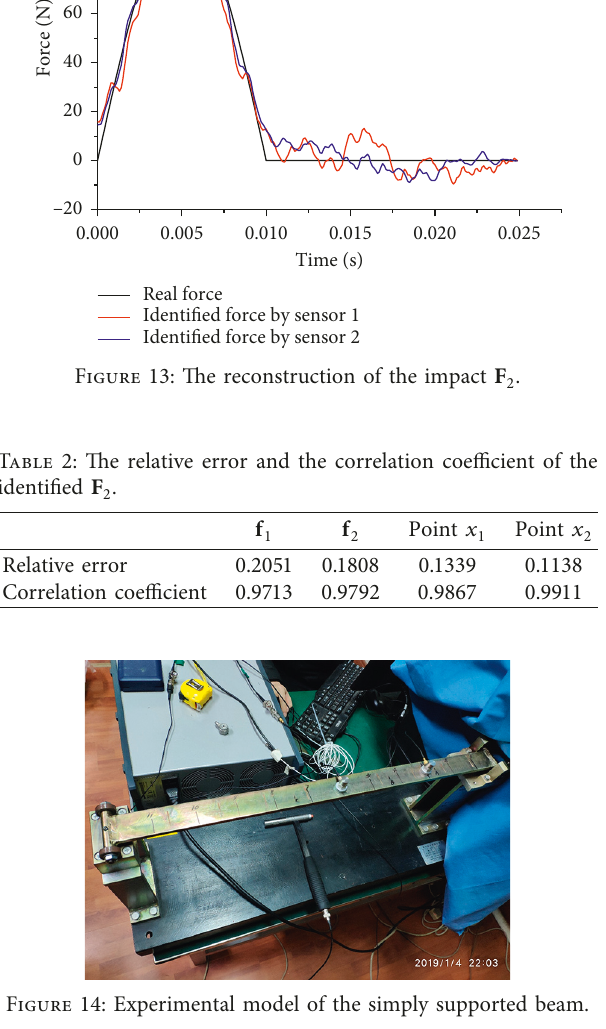
Figure 14: Experimental model of the simply supported